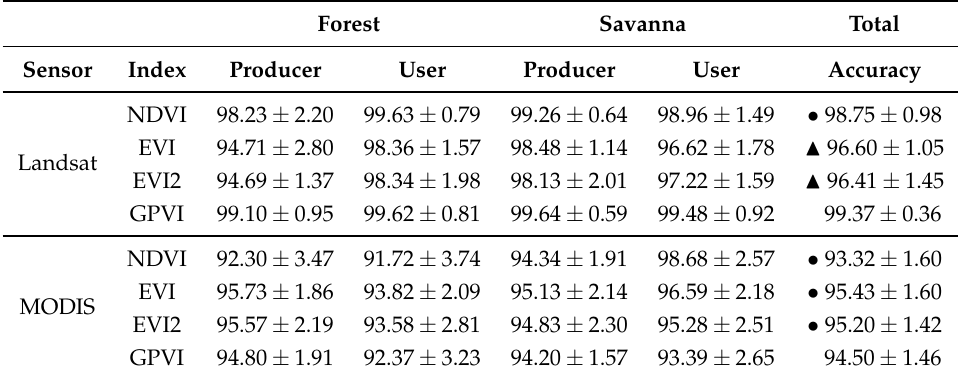
Table 6. Normalized accuracies and user’s and producer’s accuracies per class for forest/savanna time series discrimination. (cid:78) means that GPVI was statistically superior to the corresponding baseline; (cid:72) , which it was statistically inferior, and • , which both methods were tied.